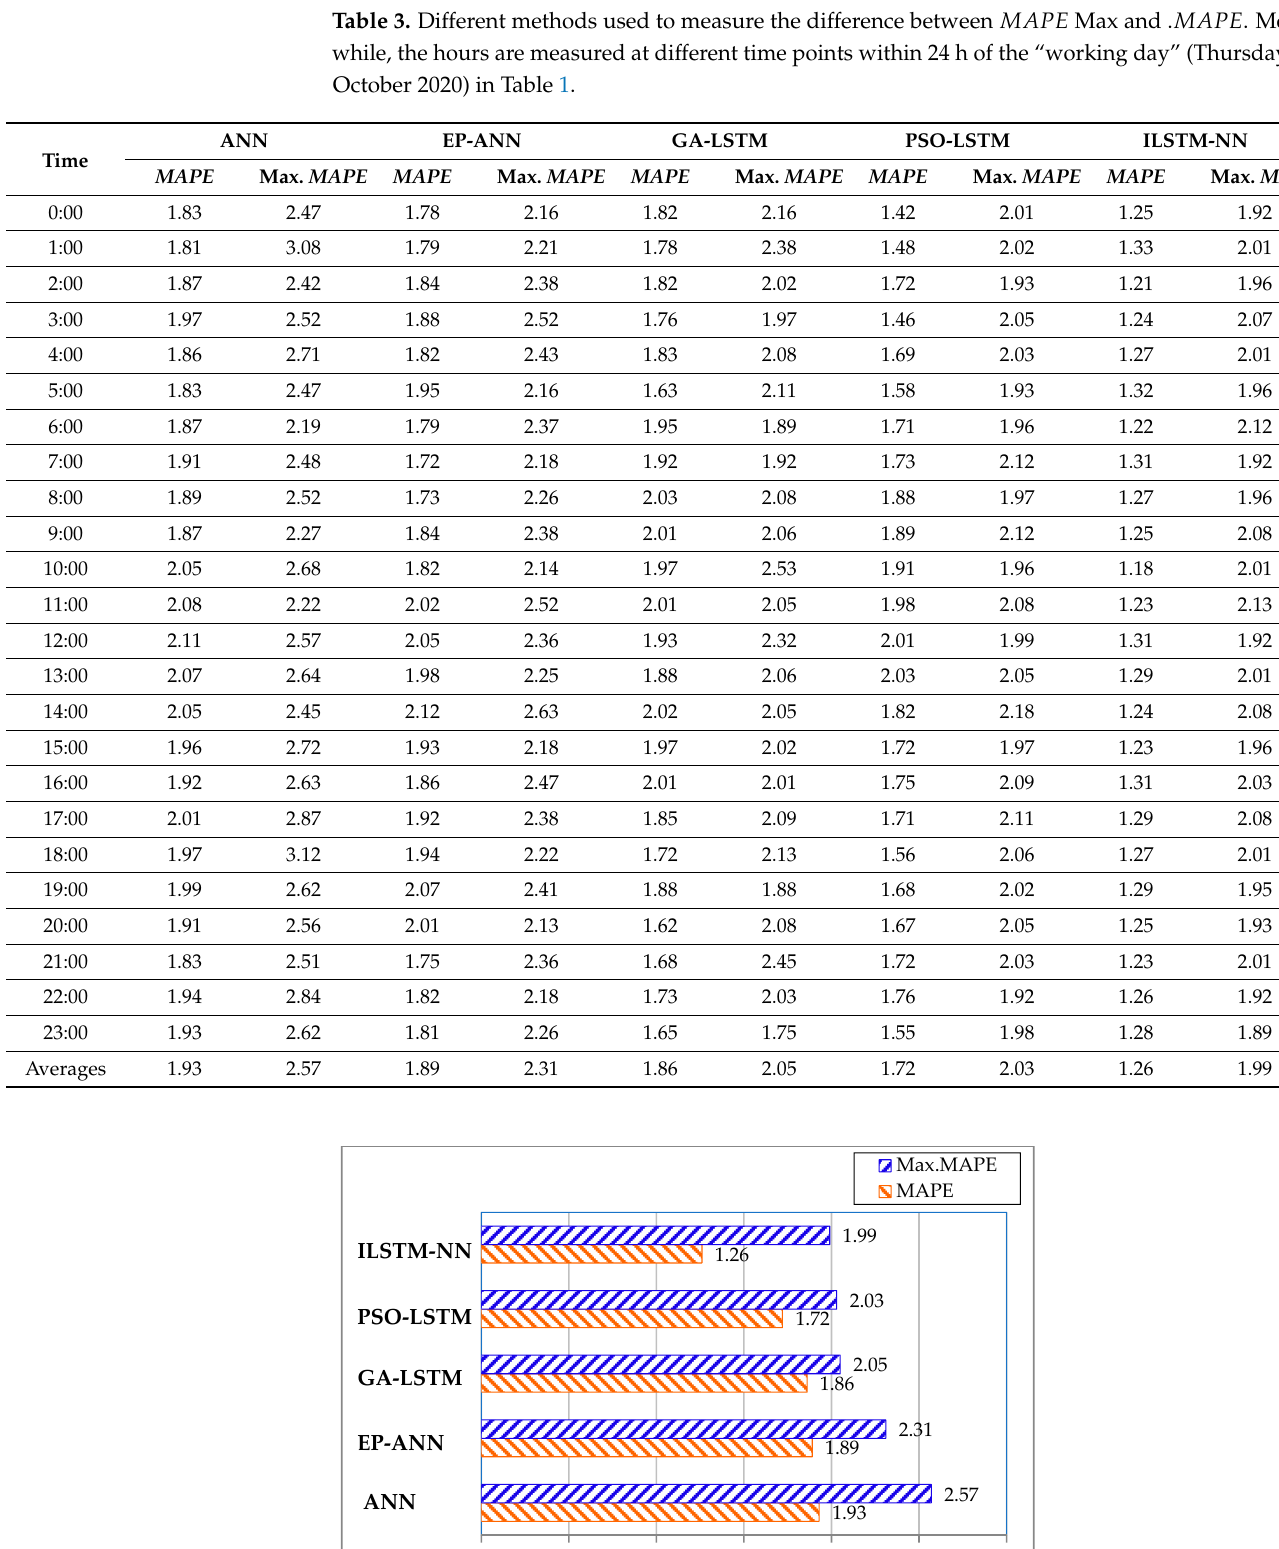
Figure 11. The MAPE and Max. MAPE of the load forecasting for a particular working day (Thursday 15 October 2020) compared with the other four different methods.